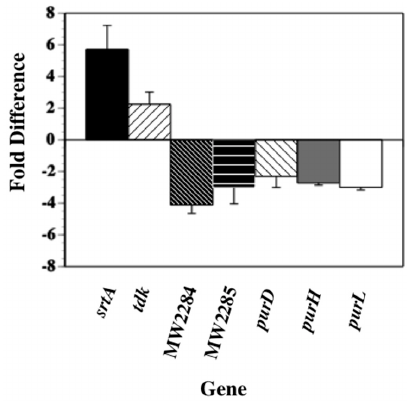
Figure 1. Quantitative reverse transcribed-polymerase chain reaction results of S. aureus MW2 cells treated with 8× the SK-03-92 MIC vs. untreated cells. The data represents the mean + standard deviation from at least three separate runs.